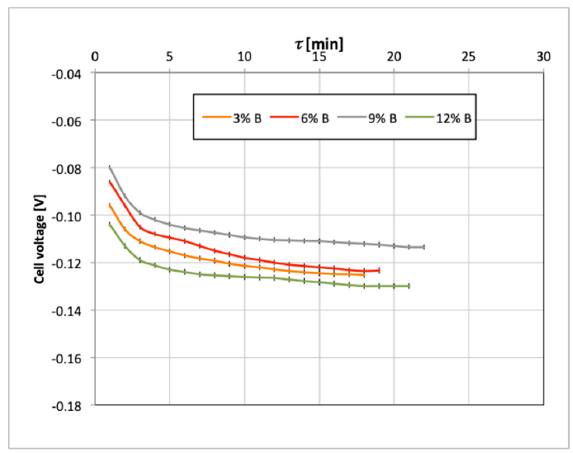
Figure 4. The electroless potential of electrodes with Cu–B catalyst which were oxidized for 6 h.